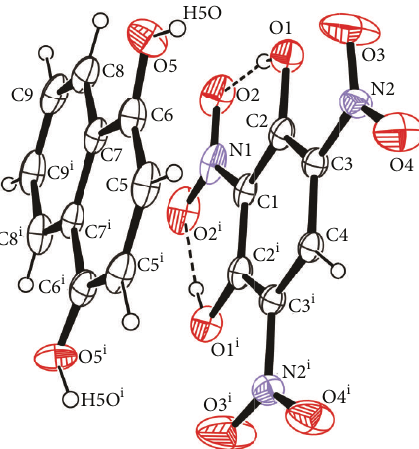
Figure 4: The asymmetric unit of the compound with the atomic labeling scheme. Displacement ellipsoids of non-H atoms are drawn at the 30% probability